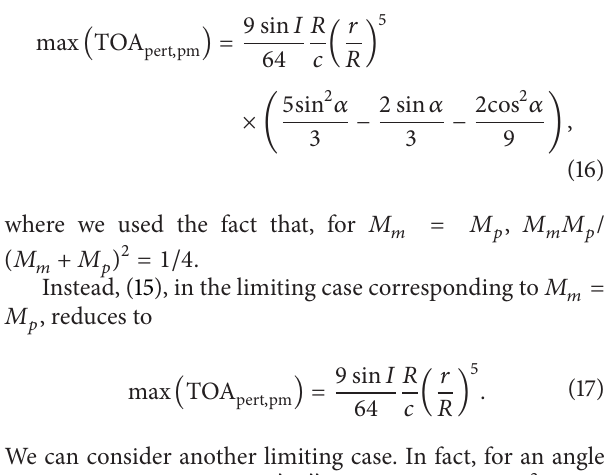
in seconds obtained from (13) for a pert , pm